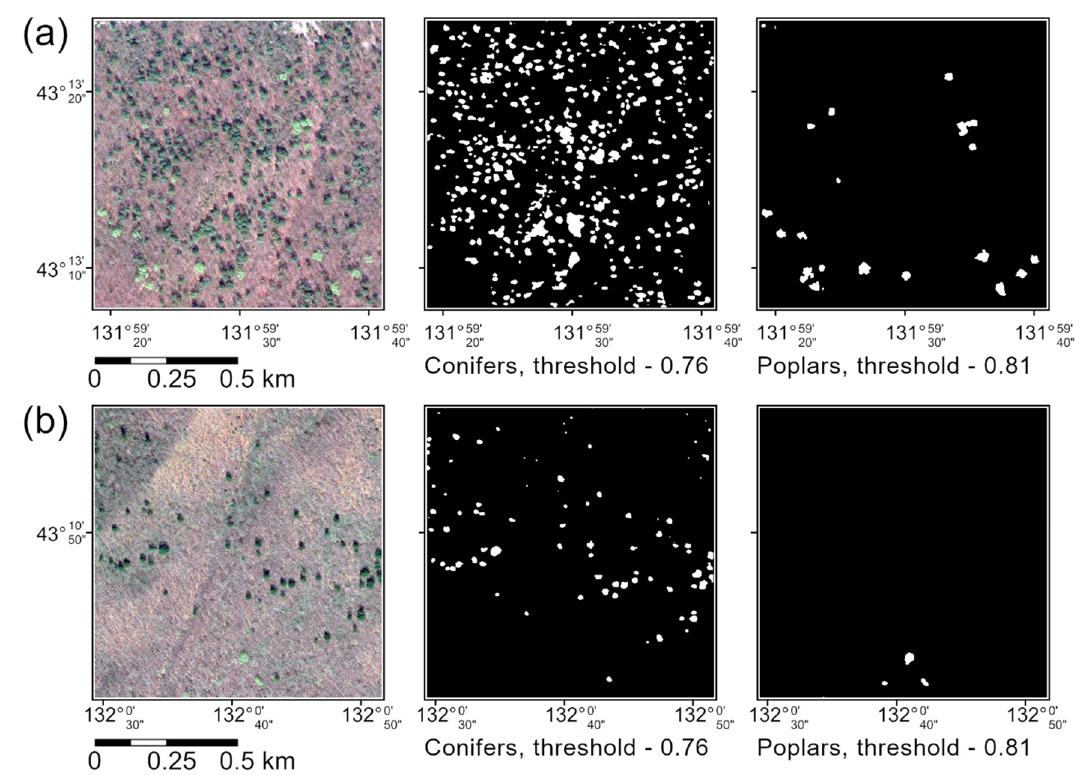
Figure 5. Results of applying the U-Net-like CNN recognition algorithm: ( a )—Train image; ( b )—Test image. Light green patches in the left images belong to poplars, and dark green patches belong to coniferous trees.